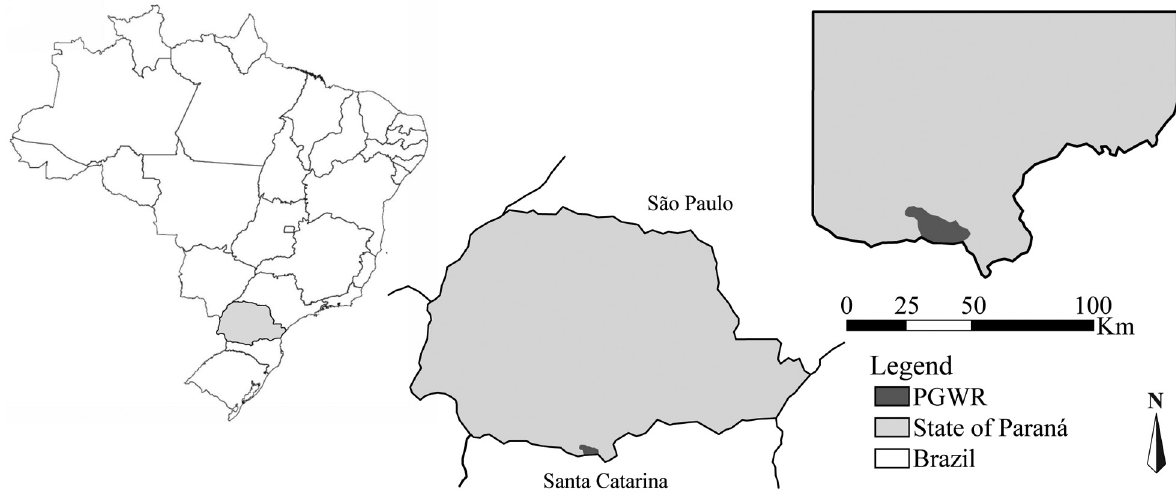
Figure 1. Location of Palmas Grasslands Wildlife Refuge (PGWR), Paraná, Brazil. Table 1. Checklist of the species of Anthomyiidae recorded to Palmas Grasslands Wildlife Refuge, Paraná, Brazil, and its respective total distribution, and number of specimens found in each studied area. *New records of distribution for Brazil. Countries abbreviations: AR, Argentina; AU, Australia; BR, Brazil; CL, Chile; LH, Lord Howe Island; NZ, New Zealand; PY, Paraguay; SA, South Africa; UY, Uruguay; US, United States. States abbreviations: AM, Amazonas; DF, Distrito Federal; MG, Minas Gerais, PR, Paraná; RJ, Rio de Janeiro; RG; SC, Santa Catarina. Area abbreviations: Af , native forest fragment; Ae, edge of native forest fragment; Ag , grasslands; Ar , regeneration area where Pinus taeda L. had been